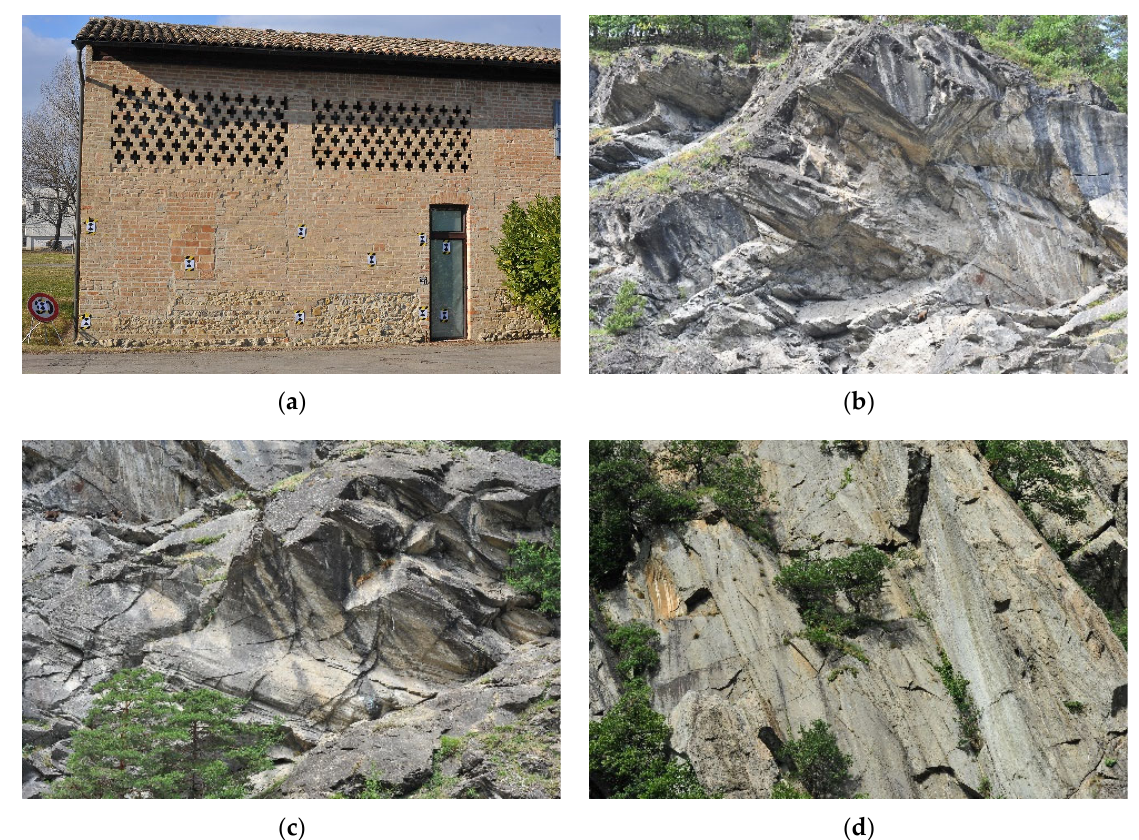
Figure 3. The four sites considered in the study: ( a ) Site A—Brick wall of a building at University of Parma. ( b ) Site B—Pollein area 1. ( c ) Site C—Pollein area 2. ( d ) Site D—Arnad.